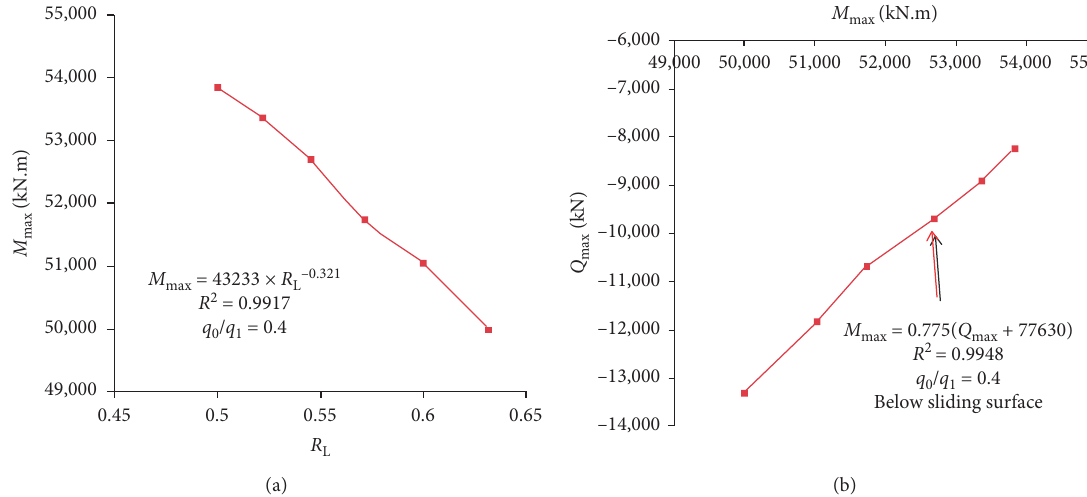
Figure 8: Calculation results of the sliding depth ratio and internal forces of the pile under different embedded lengths. (a) The relationship between the sliding depth ratio and the maximum bending moment. (b) The maximum bending moment and the maximum shear forces below the slip surface of the pile with P �